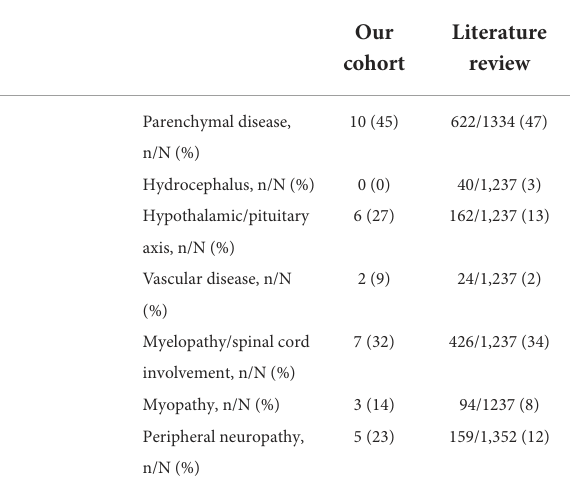
TABLE 2 Baseline and clinical characteristics of patients from our cohort and the